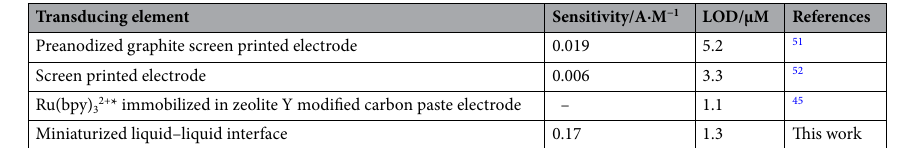
Table 3. Comparison of the electroanalytical parameters for the presumptive electrochemical heroin detection. *Ru(bpy) 32+ — tris(2,29-bipyridyl)ruthenium(II).